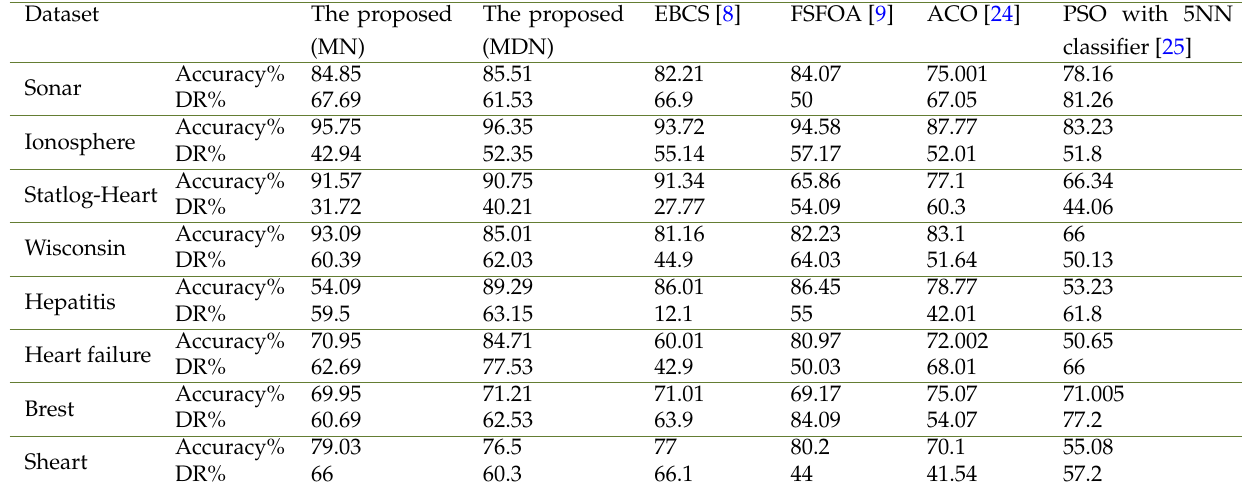
Table 2. Setting parameters for proposed Ch-BCS and previous